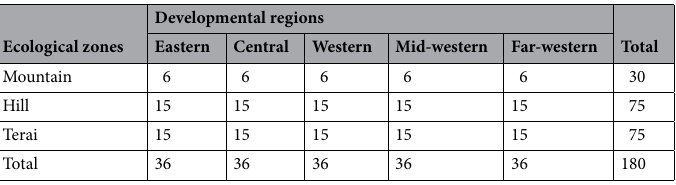
Table 5. Distribution of clusters across ecological zones and developmental